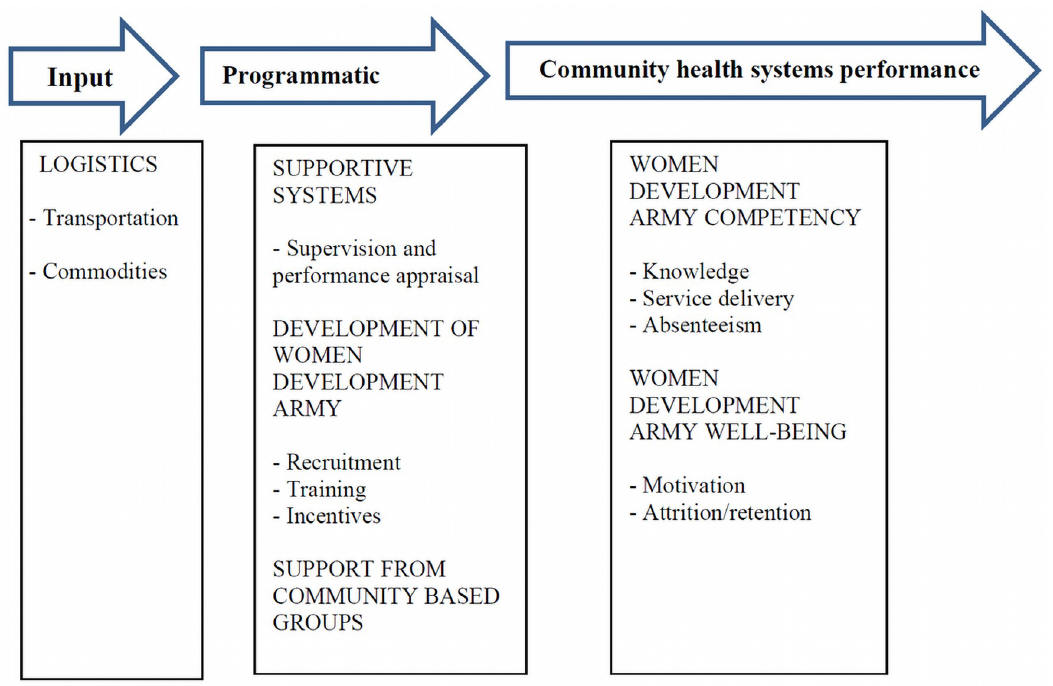
Fig 1. Adapted framework for the community health worker performance